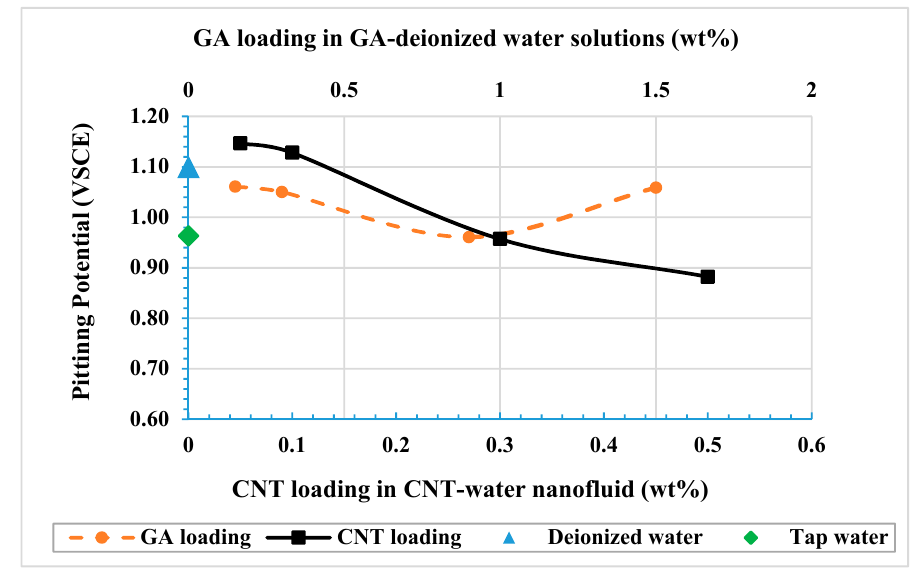
Figure 5. Effect of different loadings of CNT-water nanofluids and of GA-water solutions on the Figure 5. E ff ect of di ff erent loadings of CNT-water nanofluids and of GA-water solutions on the pitting pitting potential of 316L stainless steel. potential of 316L stainless